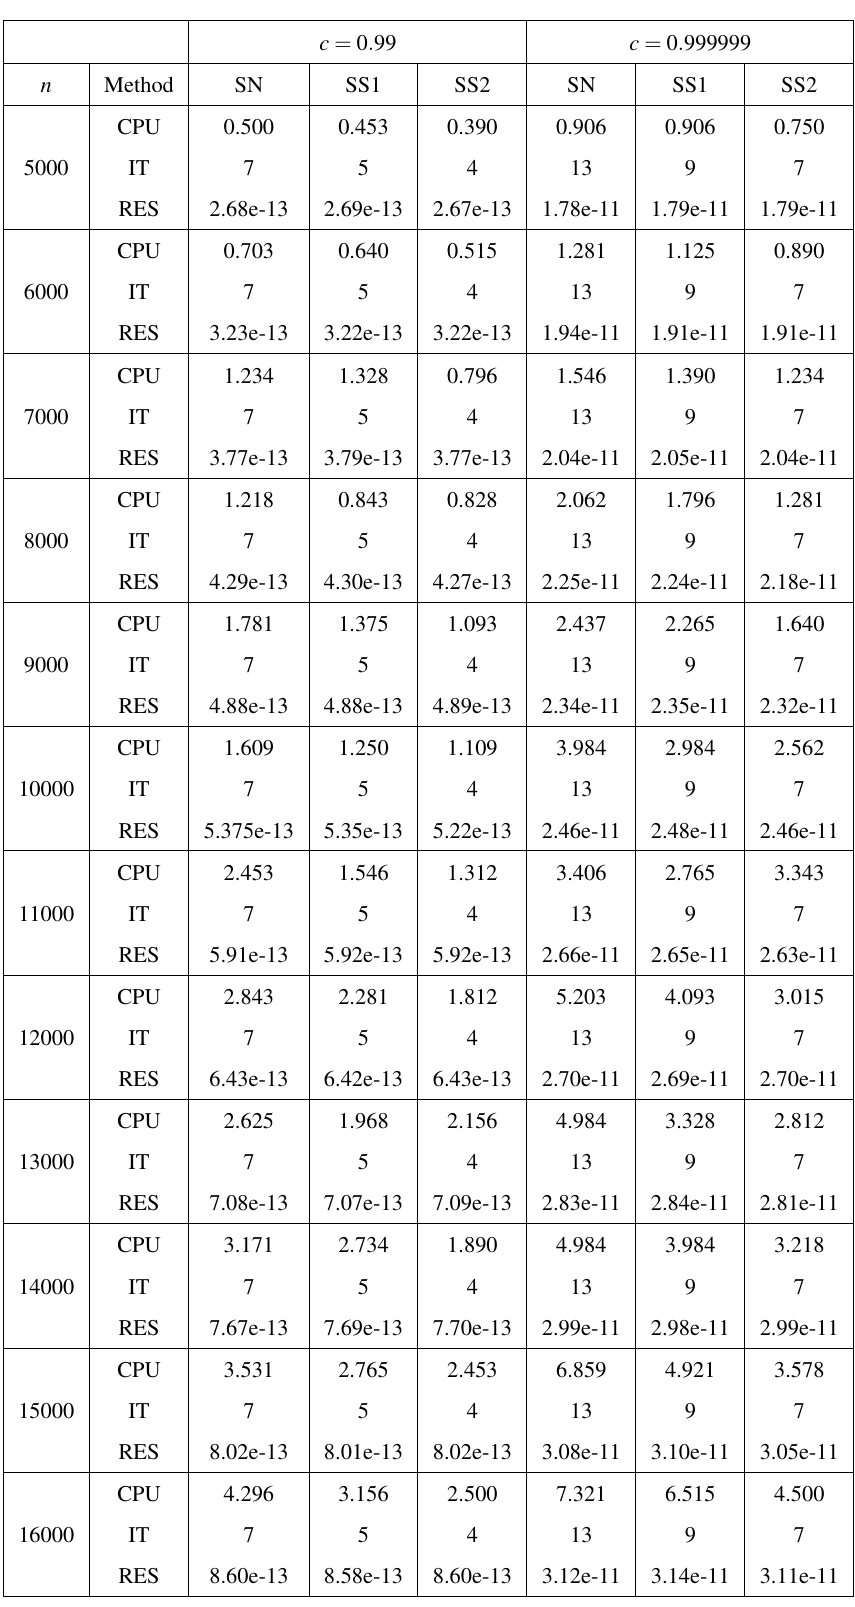
Table 2. Test results for c = 0 . 99 and c = 0 . 999999 c = 0 . 99 c = 0 .